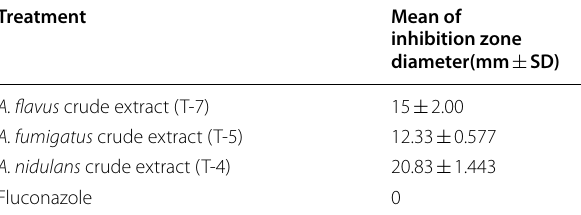
Table 1 antifungal activity of fungal ethyl acetate extracts against F.